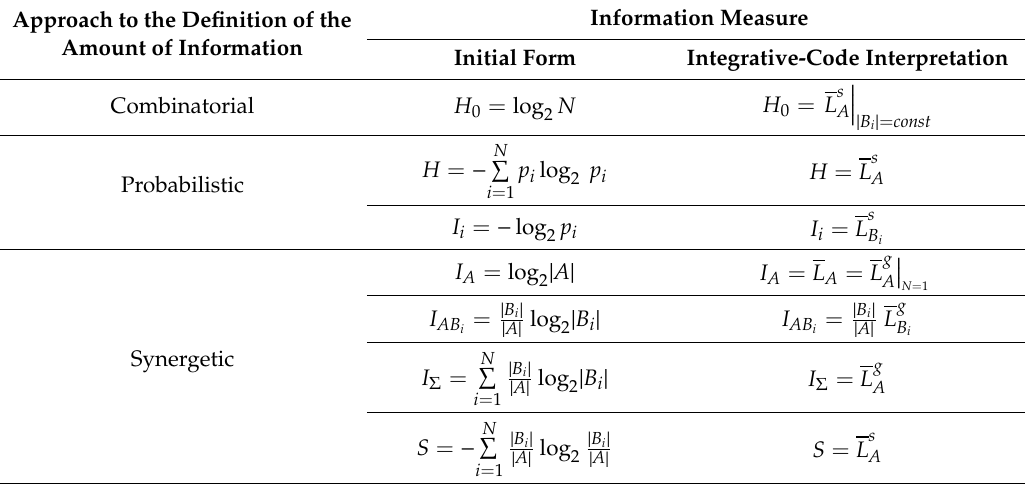
Table 4. Information measures and their integrative-code